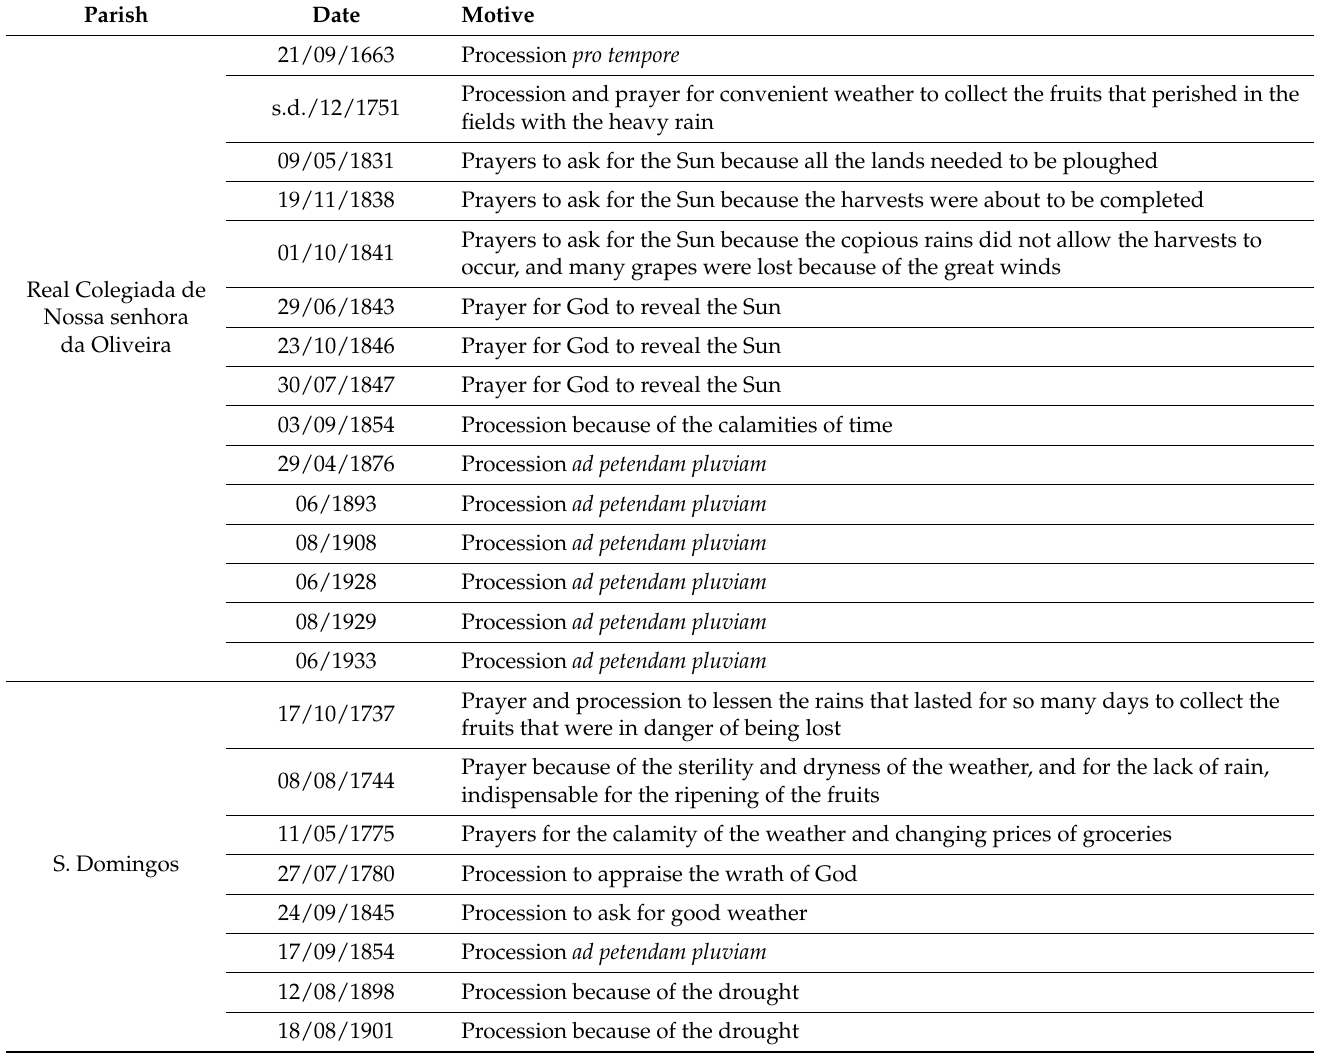
Table 2. List of processions, prayers, and masses held to ask for divine intercession to improve weather conditions from the 16th to the 20th centuries, recorded by Alberto Vieira Braga, in 1943, in the work “ Cercos e Clamores